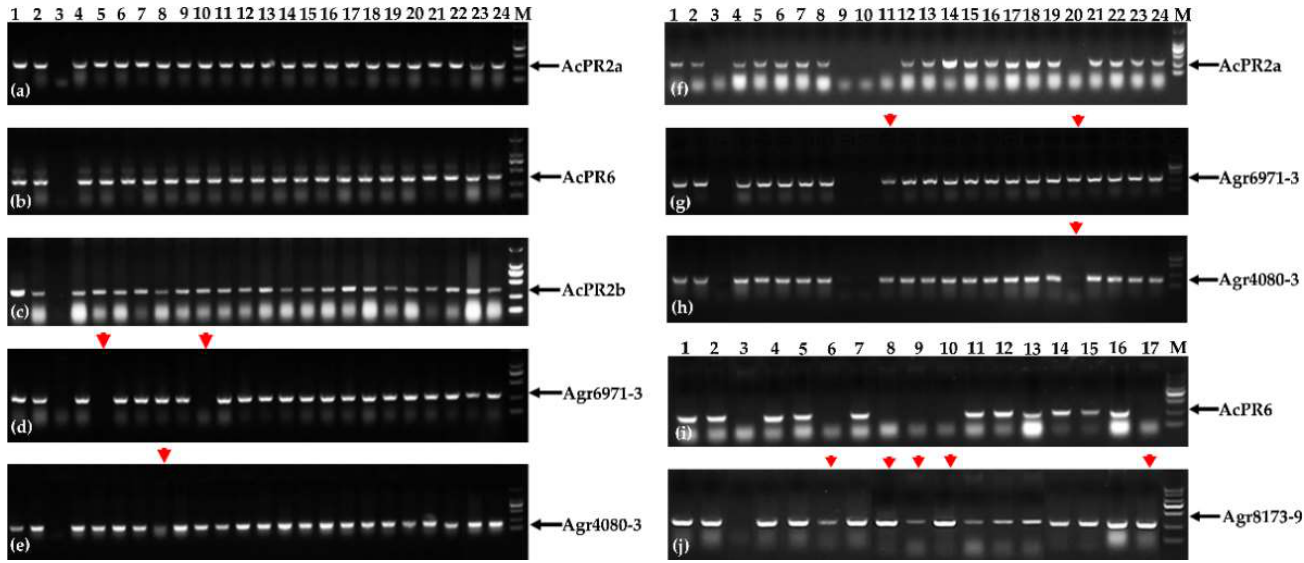
Figure 2. Then PCR amplification patterns of A . cristatum P genome-specific markers (AcPR2a, AcPR6, and AcPR2b) and gene makers (Agr6971-3, Agr4080-3, and Agr8173-9) in the genetic populations (BC 5 F 2 and BC 5 F 2:3) . ( a – e ) The detection results for the BC 5 F 2 population of the translocation line WAT655. ( f – j ) The detection results for the BC 5 F 2:3 population of the translocation line WAT655. The red arrows indicated the differences between P genome-specific markers and the gene makers in these plants; the black arrows indicated the diagnostic bands. Lanes: M, DL2000 DNA marker; 1, Z559; 2, 4844-12; 3, Fukuho; 4–24 of ( a – e ) the partial plants of the BC 5 F 2 population; 4–24 of ( f – h ) the partial plants of the WAT655 BC 5 F 2:3 population; 4–17 of ( i , j ) the partial plants of the BC 5 F 2:3